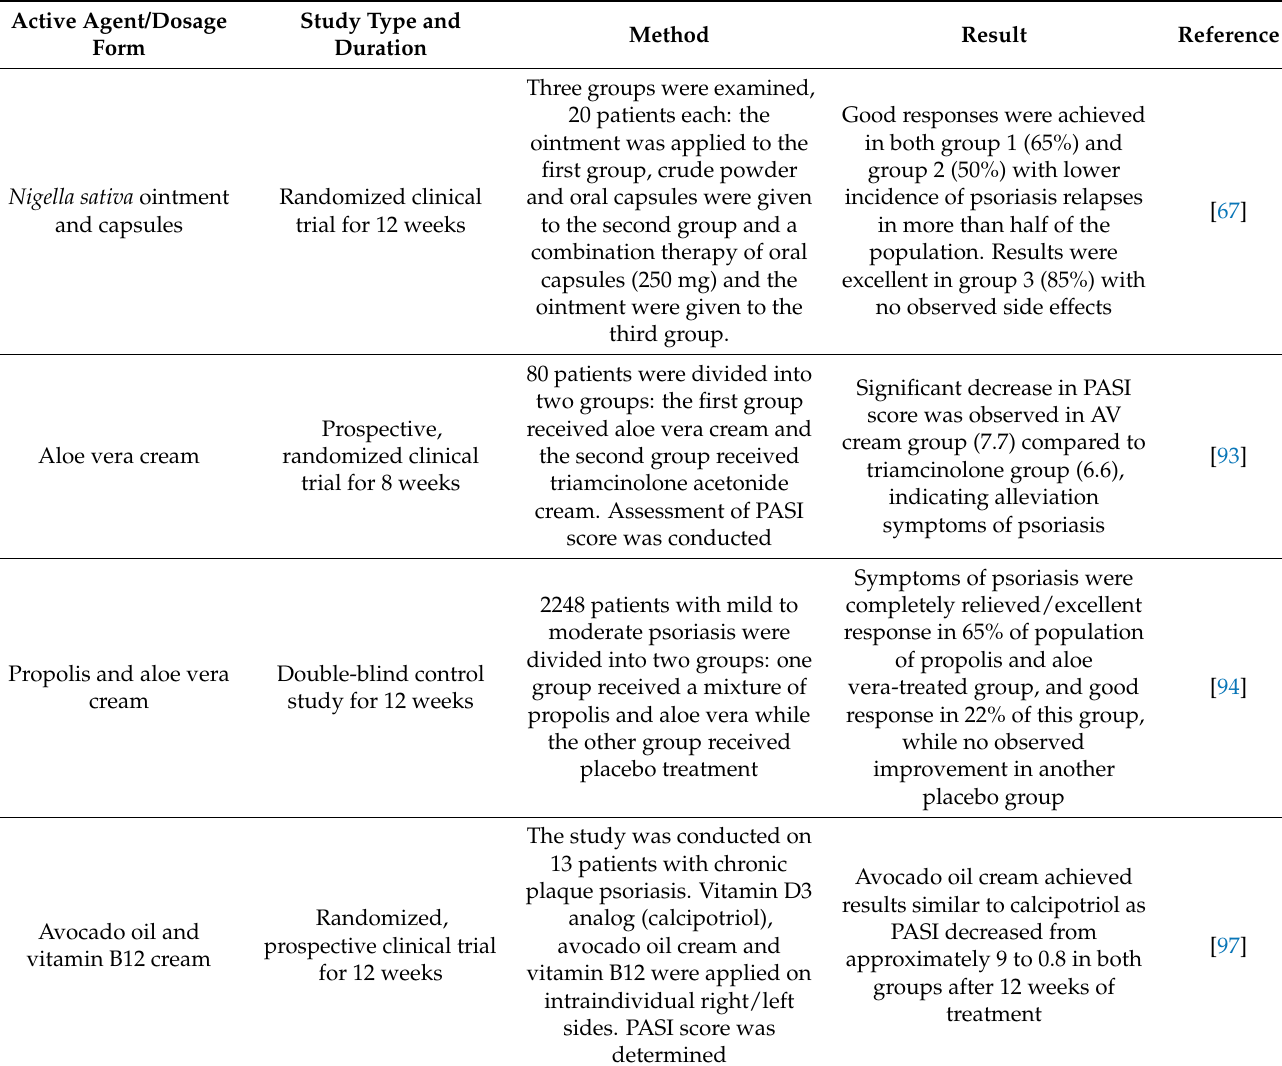
Table 2. A summary of clinical studies that assessed botanical agents/essential oils employed in the treatment of